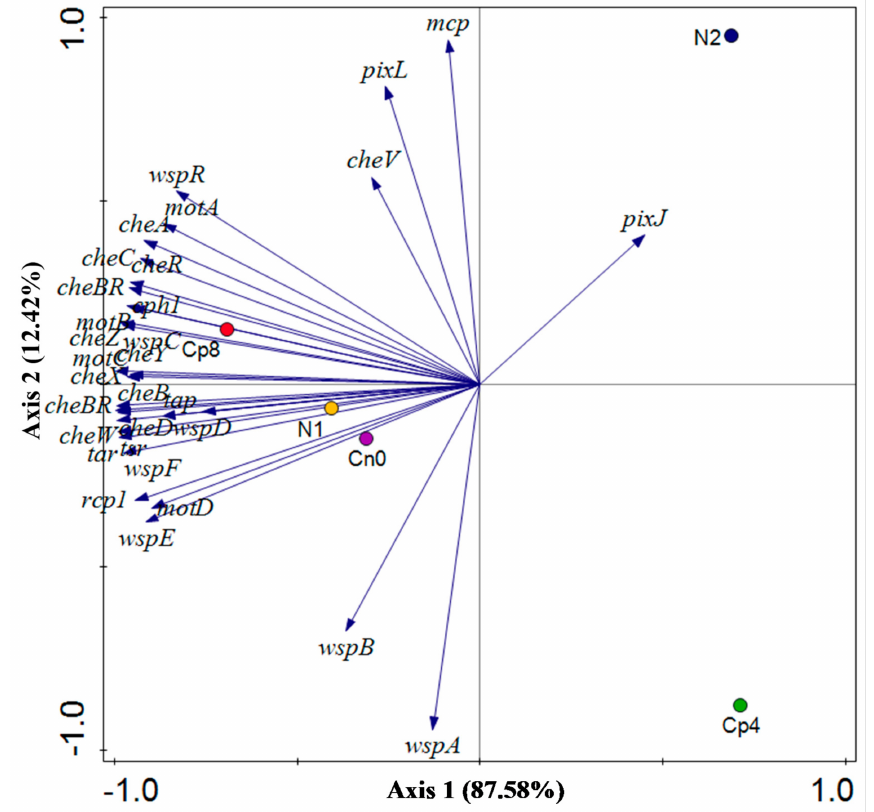
Figure 5. PCA—principal component analysis of the chemotaxis genes abundance within the maize rhizosphere treated with organic, inorganic fertilizer, and untreated control Cn0 (control), Cp8 (8 tons/ha compost manure), Cp4 (4 tons/ha compost manure), N2 (120 kg/ha inor- ganic fertilizer) and N1 (60 kg/ha inorganic